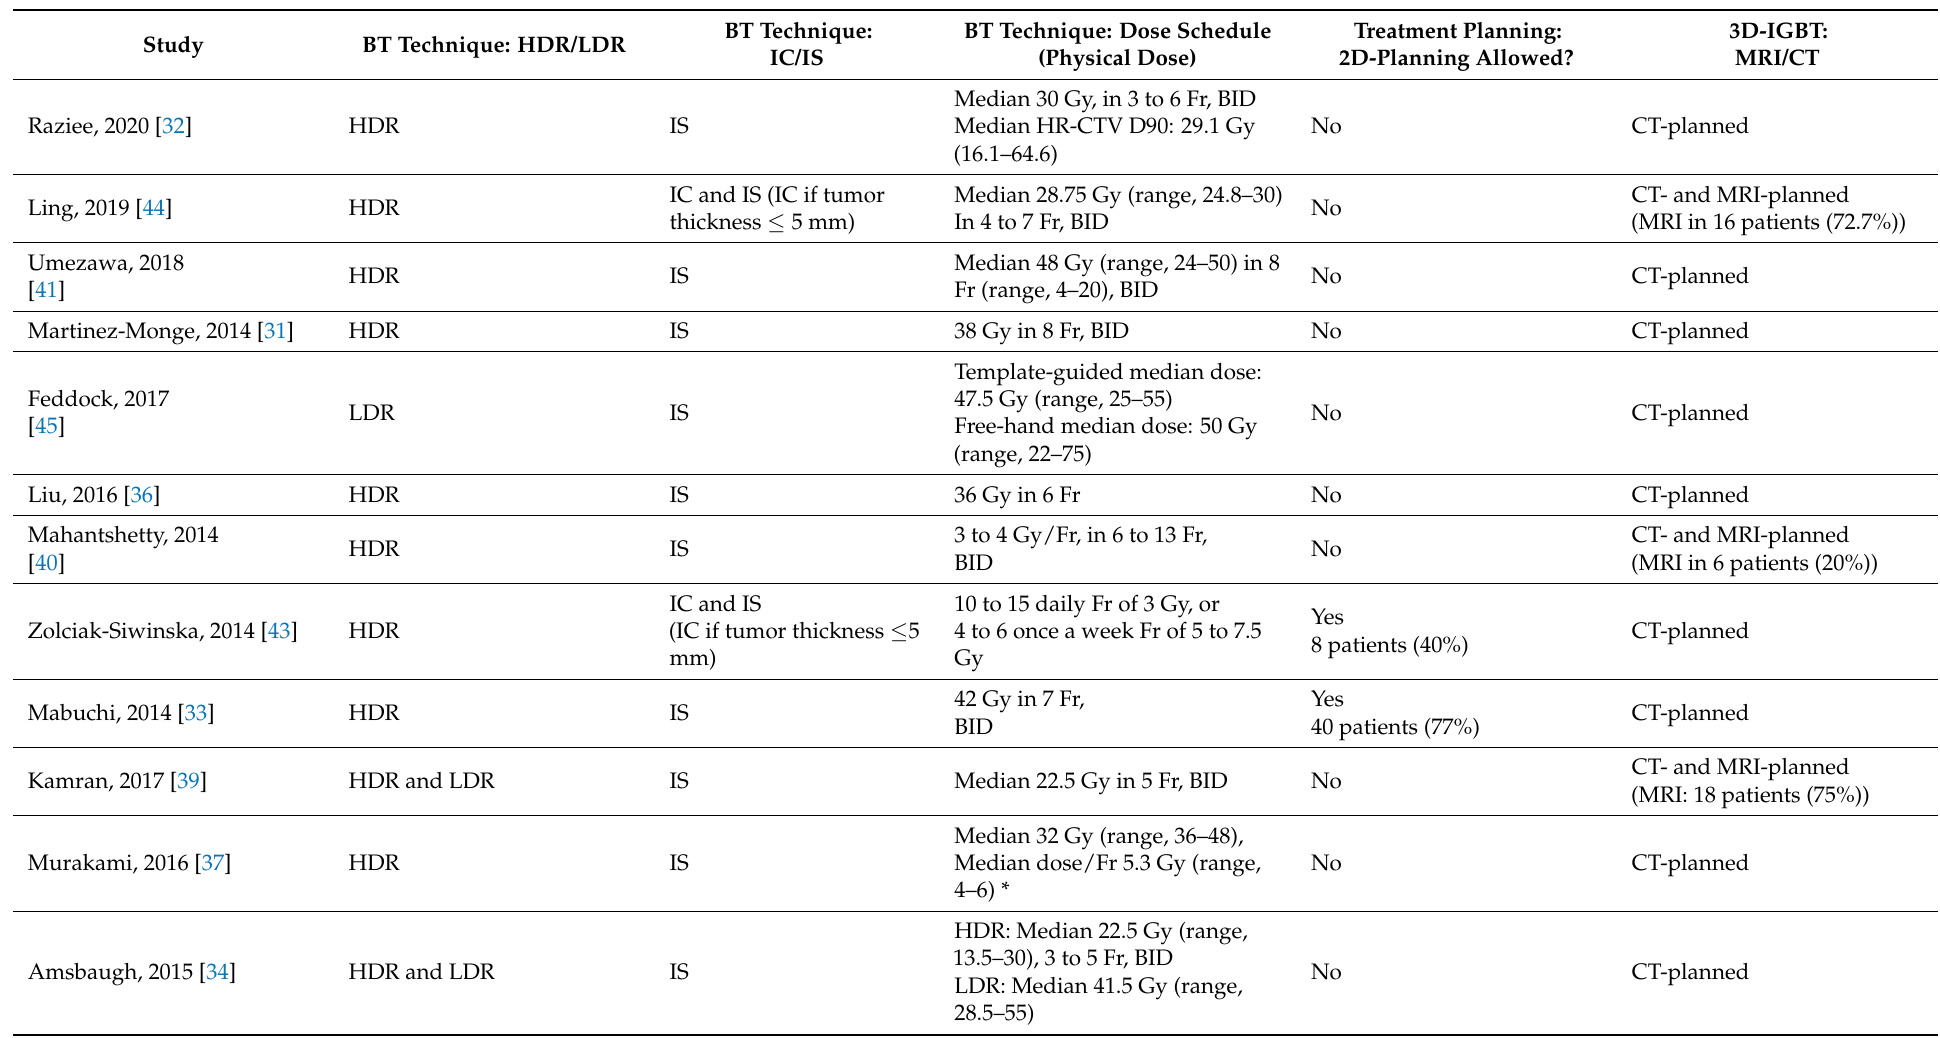
Table 2. Reirradiation 3D-IGBT studies: BT and EBRT technique and